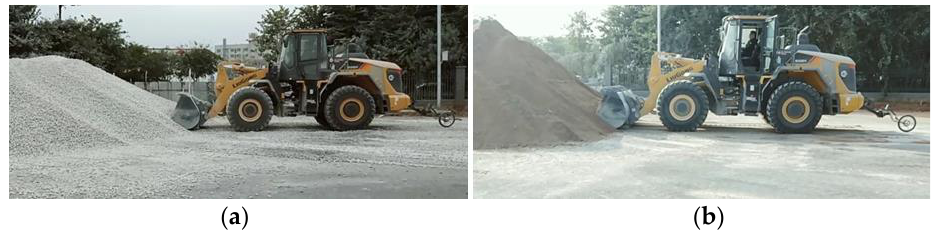
Figure 1. Wheel loader inserts into the pile. ( a ) The insertion of gravel; ( b ) The insertion of sand.